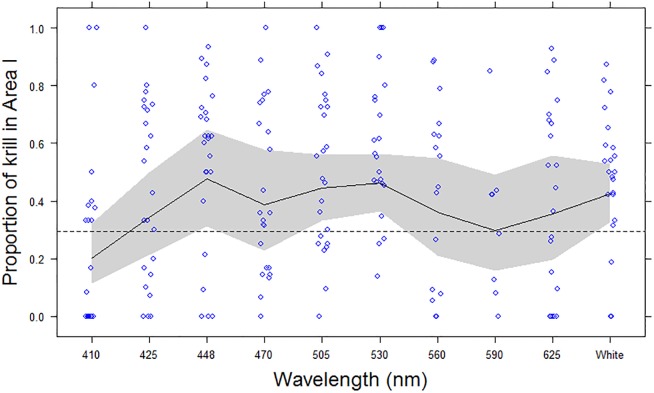
The proportion of active krill in Area I, related to wavelength and intensity.The proportion of active krill (Maganyctiphanes norvegica) observed in Area I during replicate treatments (blue circles) and GEE fitted values (Black line) with 95% confidence intervals (grey shaded band), with respect to wavelength. The expected proportion of active krill observed in area I (i.e. p = 0.2941), if just randomly distributed, is shown with a dashed (---) line. X-axis is not to scale, and for comparison broadband white light (400-800nm) is displayed at the end.